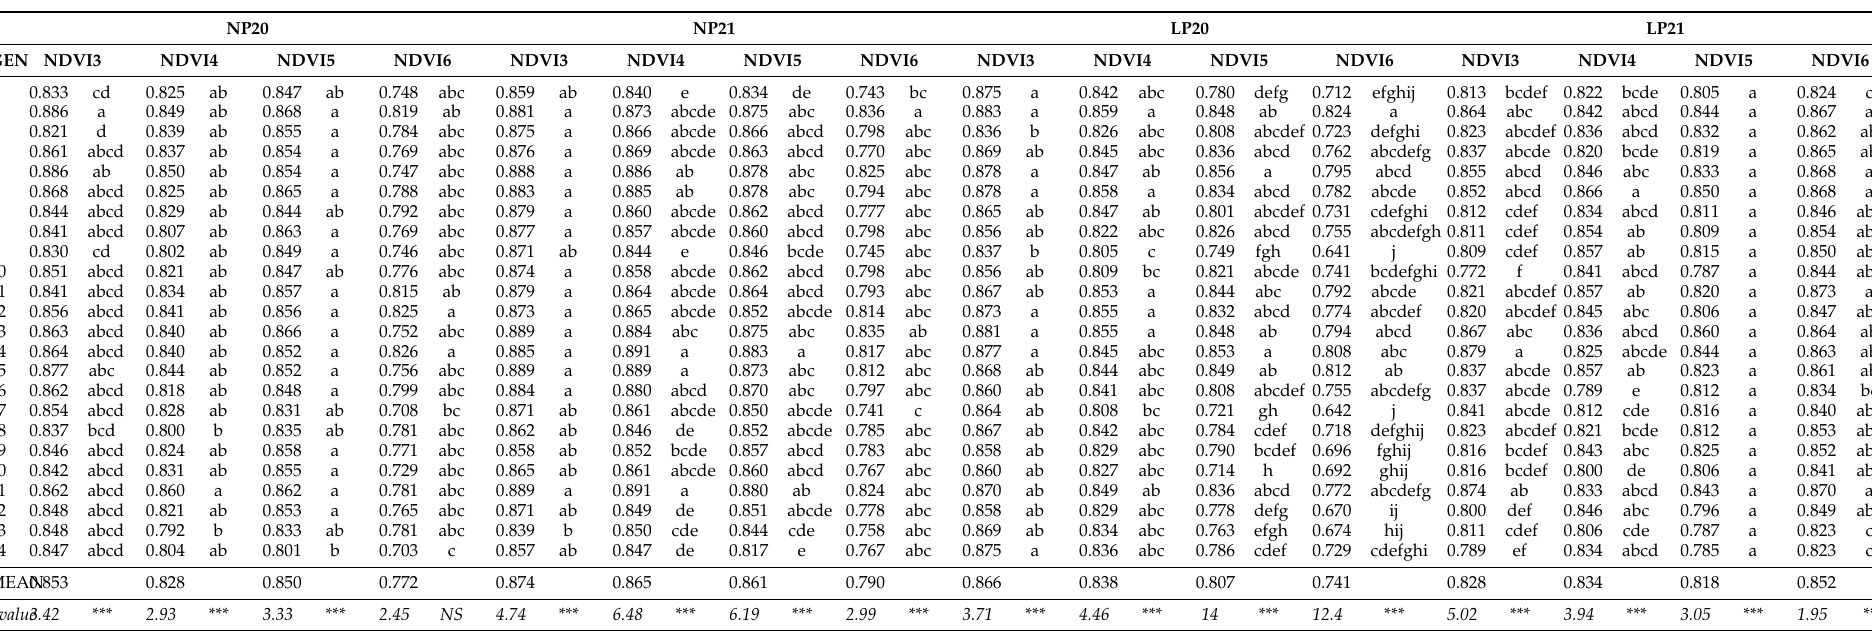
Table 4. Average NDVI index value by genotype at four monitoring dates. The specific monitoring covers the period from the middle of the reproductive stage till the beginning of the ripening stage. Means and ANOVA F values to verify the occurrence of genetic variation among lines for each